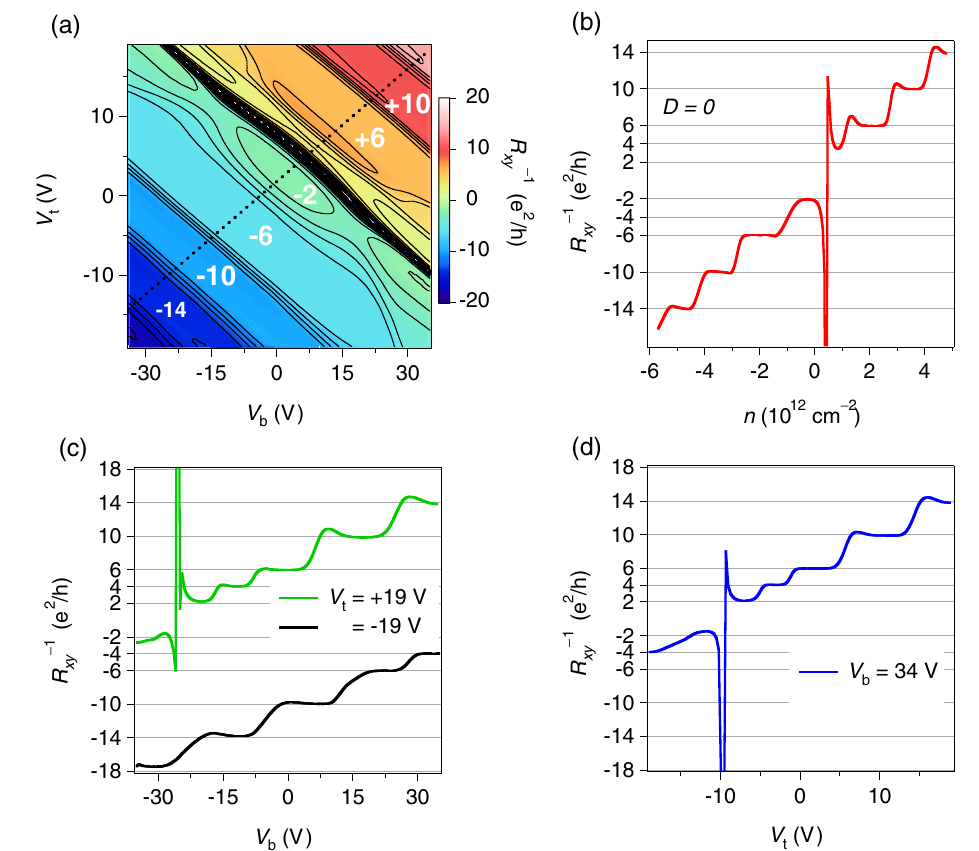
FIG. 3. (a) The ABA-stacked trilayer quantum Hall effect, plotted as the inverse Hall resistance, R (cid:1) 1 xy , vs V b and V t at B ¼ 14 T . Contour lines are drawn at filling factors (cid:7) ¼ . . . (cid:1) 1 : 5 , (cid:1) 0 : 5 , þ 0 : 5 , þ 1 : 5 . . . . The quantum numbers of several plateaus are indicated in white. Several profile cuts through the data to highlight the various quantized plateaus are shown in (b), (c), and (d). The cut in (b) is taken along D ¼ 0 following the dashed line in (a). The cuts for (c), for constant top gate voltages, are taken along the top and bottom edges of (a). The cut for (d) is taken along the right edge of